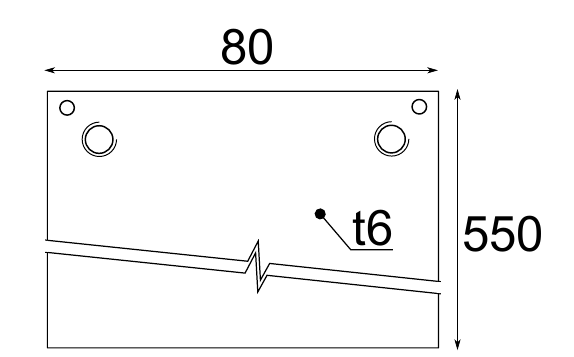
Fig. 1. Dimensions and mounting positions of acceleration sen- sors